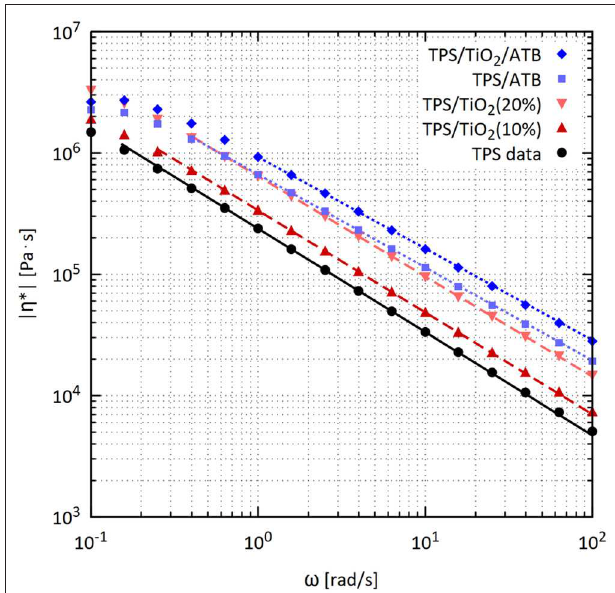
FIGURE 5 | Frequency sweep from oscillatory shear rheometry: absolute values of complex viscosities of the TPS/TiO 2 /ATB composites at 120 ◦ C and strain of 0.05%, including comparison of the experimental points and their fitting with a power-law model (description of model in Ostafinska et al.,